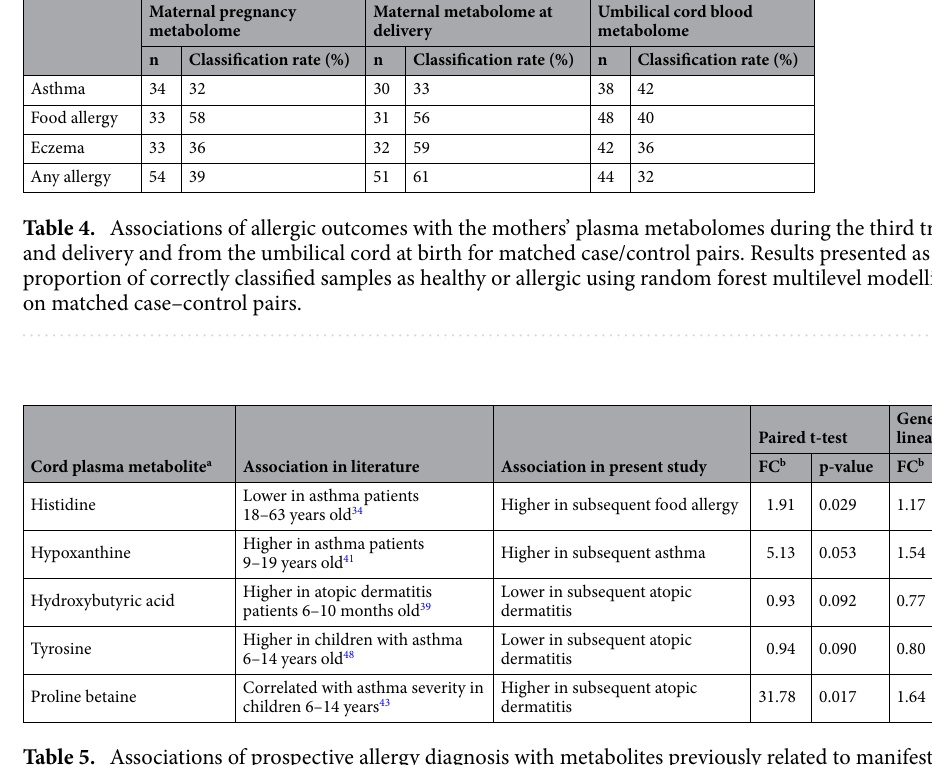
Table 5. Associations of prospective allergy diagnosis with metabolites previously related to manifest allergy. a All metabolite associations reported for cord plasma. No associations were observed with the maternal plasma metabolites. b Data presented as fold change (FC), with FC > 1 indicating a positive association with